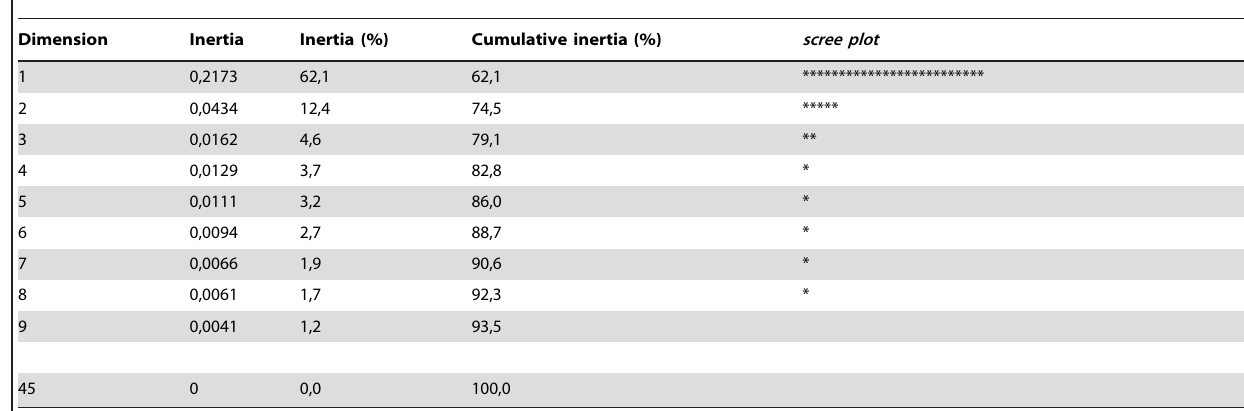
Dimension Inertia Inertia (%) Cumulative inertia (%)